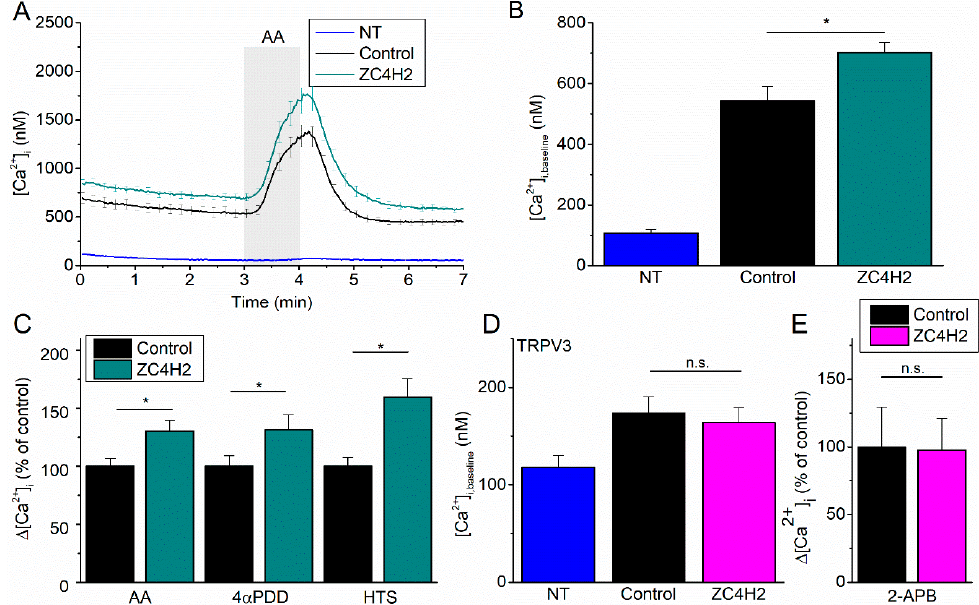
Figure 2. E ff ect of ZC4H2 on TRPV4 channel activity. ( A ) Time course of the intracellular Ca 2 + concentration ([Ca 2 + ] i ) (mean ± SEM) in non-transfected (NT) HEK-293T cells ( n = 30), and cells co-transfected with TRPV4 and mCherry (control, n = 79) or ZC4H2-mCherry ( n = 80), upon stimulation with arachidonic acid (AA; 10 µ M). ( B ) Mean baseline [Ca 2 + ] i in experiments as in (A). ( C ) Normalized [Ca 2 + ] i amplitudes in response to the TRPV4-activating stimuli AA (10 µ M), 4 α -PDD (10mM), or hypotonic solution. Values are normalized to the response of cells expressing TRPV4 and mCherry. Representative traces are shown in Figure A3. ( D ) Co-expression of ZC4H2 is without e ff ect on baseline [Ca 2 + ] i in cells expressing TRPV3 ( n = 144 for ZC4H2 co-transfected, 183 for control, n = 26 for non-transfected). ( E ) Normalized [Ca 2 + ] i amplitudes in TRPV3-expressing cells in response to the agonist 2-APB (25 µ M). Values are normalized to the response of cells expressing TRPV3 and mCherry. p -values < 0.05 were considered significant